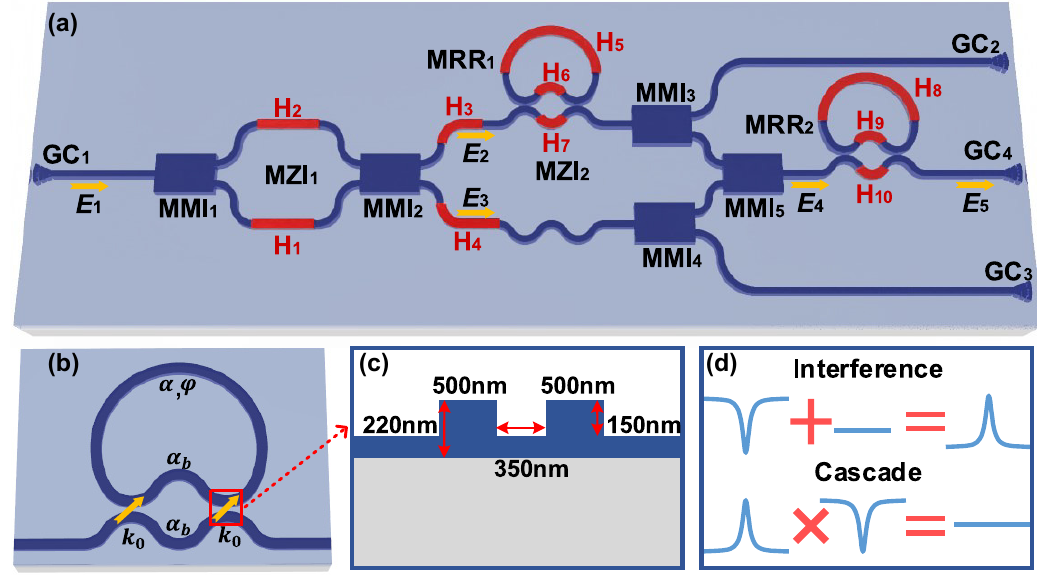
Figure 1: Principle. (a) Schematic diagram of the proposed APF. MRR, microring resonator; MMI, multimode interferometer; MZI, Mach–Zehnder interferometer; GC, grating coupler. The yellow arrows represent the propagation of the optical field. (b) Schematic diagram of the MRR with an adjustable coupling coefficient based on the MZI coupler. (c) Cross section of the coupling region. (d) Depiction of the principle of the second-order